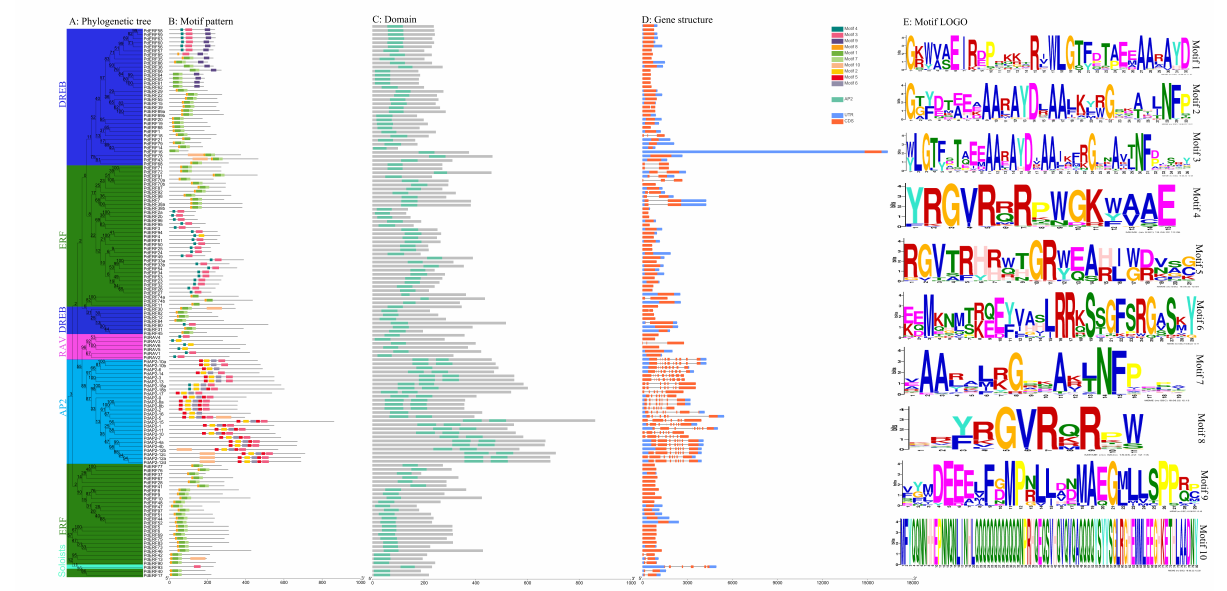
Figure 2. Phylogenetic clustering of PdAP2/ERF members based on motifs and gene structures. ( A ) Neighbor-joining phylogenetic tree of members of the PdAP2/ERF family. Different colored areas represent different groups. ( B ) Conserved protein motifs. ( C ) AP2 domains. ( D ) Gene structures. ( E ) Motif LOGO. The ruler at the bottom of B and C figures represents the length of amino acids. The ruler at the bottom of D figure represents the number of nucleotides (base pair: